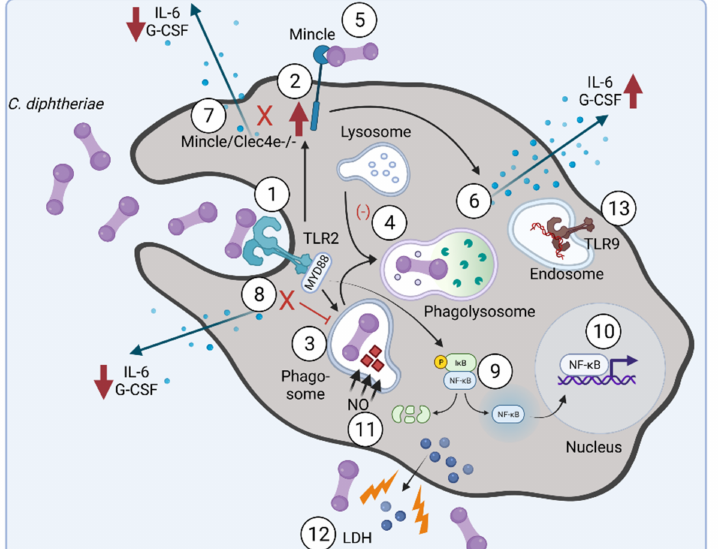
Figure 4. C. diphtheriae recognition by macrophages. Binding of C. diphtheriae by TLR2 (1) leads on the one hand to upregulation of the C-type lectin receptor Mincle (2) and on the other hand to phagocytosis of the bacteria (3), resulting in phagosome–lysosome fusion, which is somehow delayed by C. diphtheriae (4). Furthermore, binding of C. diphtheriae to Mincle (5) triggers the production of pro-inflammatory cytokines (6), which was confirmed by reduced cytokine production in Clec4e- deficient cells (7). Additionally, in Myd88-deficient cells the cytokine production as well as the uptake of the bacteria was completely blocked (8). Further signs of inflammation caused by pathogenic corynebacteria are the activation of NF κ -B-signaling (9), resulting in upregulation of pro-inflammatory genes (10), and the production of nitric oxide (NO) (11). In the case of the infection of THP-1 cells, a cytotoxic effect of C. diphtheriae was detectable by LDH release (12). TLR-9 activation can be observed for non-toxigenic strains (13) [58] (figure created with